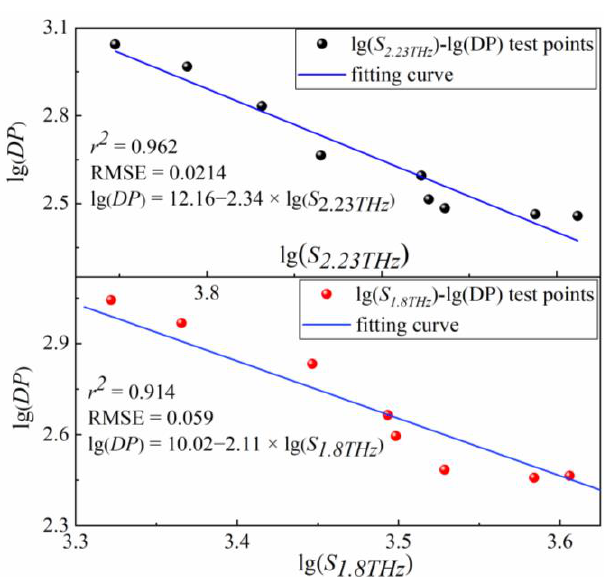
Figure 6. Double-logarithmic linear relationship of lg (S 1.8THz ) , lg (S 2.23THz ) , and lg(DP).